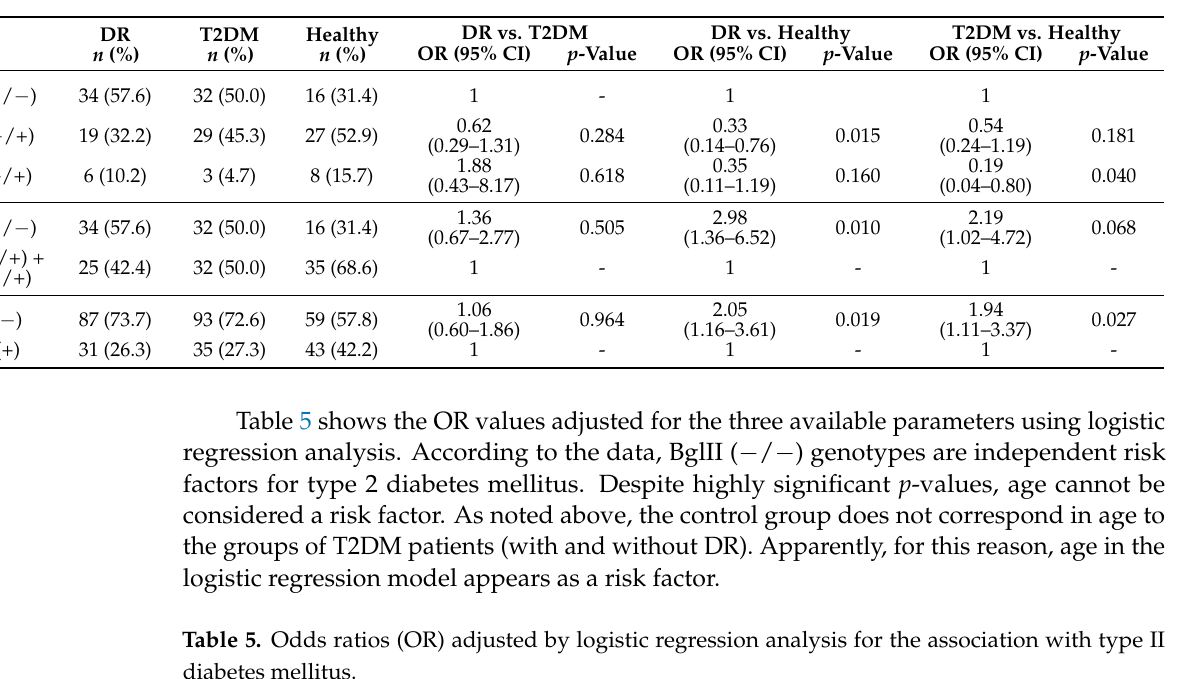
Table 4. Association analysis of the ITGA2 gene BglII polymorphism in Kazakhs group.